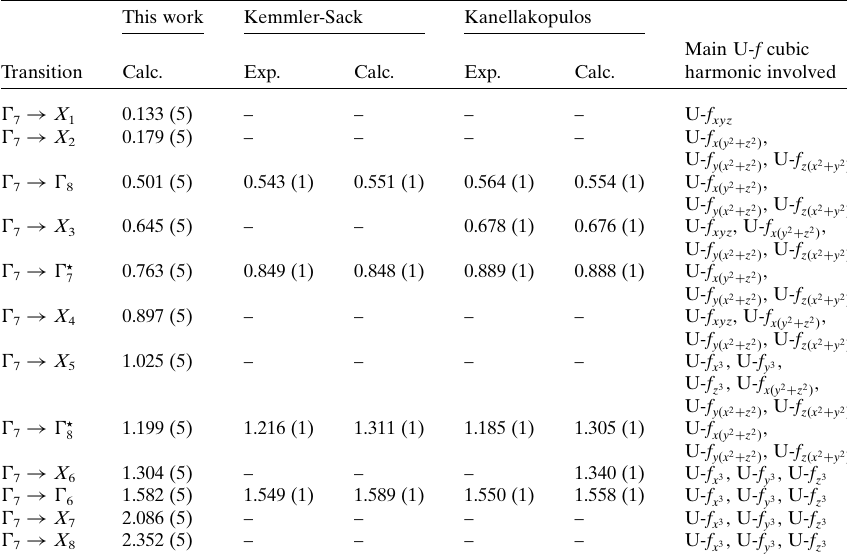
Table 3 Crystal field splitting energies (all in eV) of the U-5 f electronic levels above the (cid:4) 7 ground state in KUO 3 . Those peaks are contributing to the white line intensity in the U M 4 -edge HERFD-XANES spectra. Experimental forbidden Laporte f – f transition (cid:4) 7 ! (cid:4) n from Kemmler-Sack (1968) and from Kanellakopulos et al. (1980) were initially reported in cm (cid:4) 1 units, and are here converted to eV units. Additional predicted transitions (cid:4) 7 ! X n are also indicated. The most significant U- f cubic harmonics for each state are also reported (see text for more details).